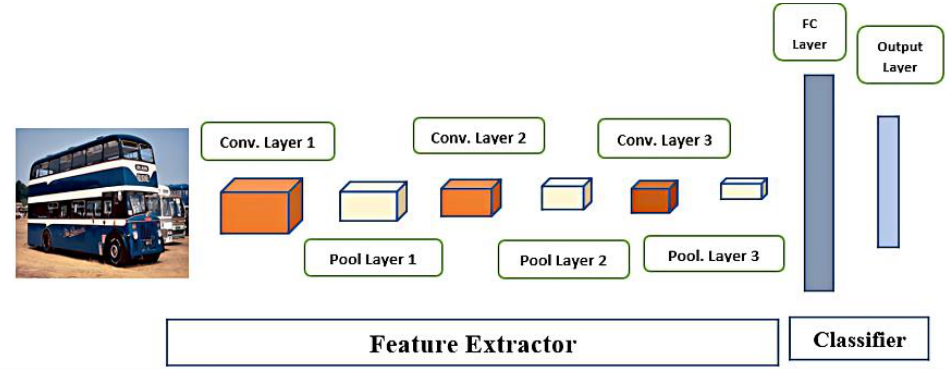
Figure 8. Overview of CNN architecture.